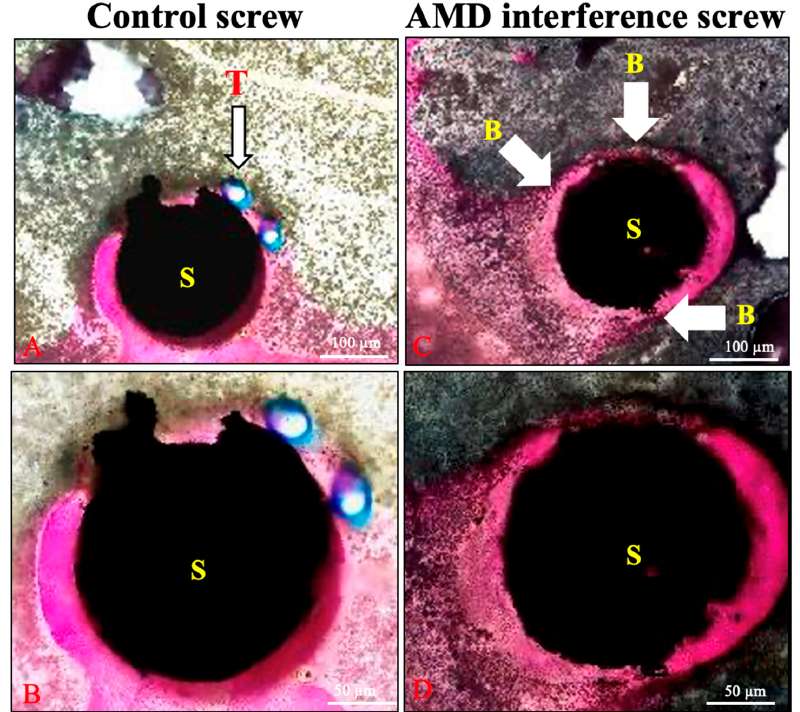
Figure 7. Histological examination of the 6-month specimens. More woven bone formation (wide arrows) was identified in the bone–screw construct in the AMD screw group. The tendon graft (line arrow) is shown between the screw and bone in the control group ( A , B ). The bone and screw were in close contact in the AMD screw group ( C , D ); B: bone, T: tendon, and S: